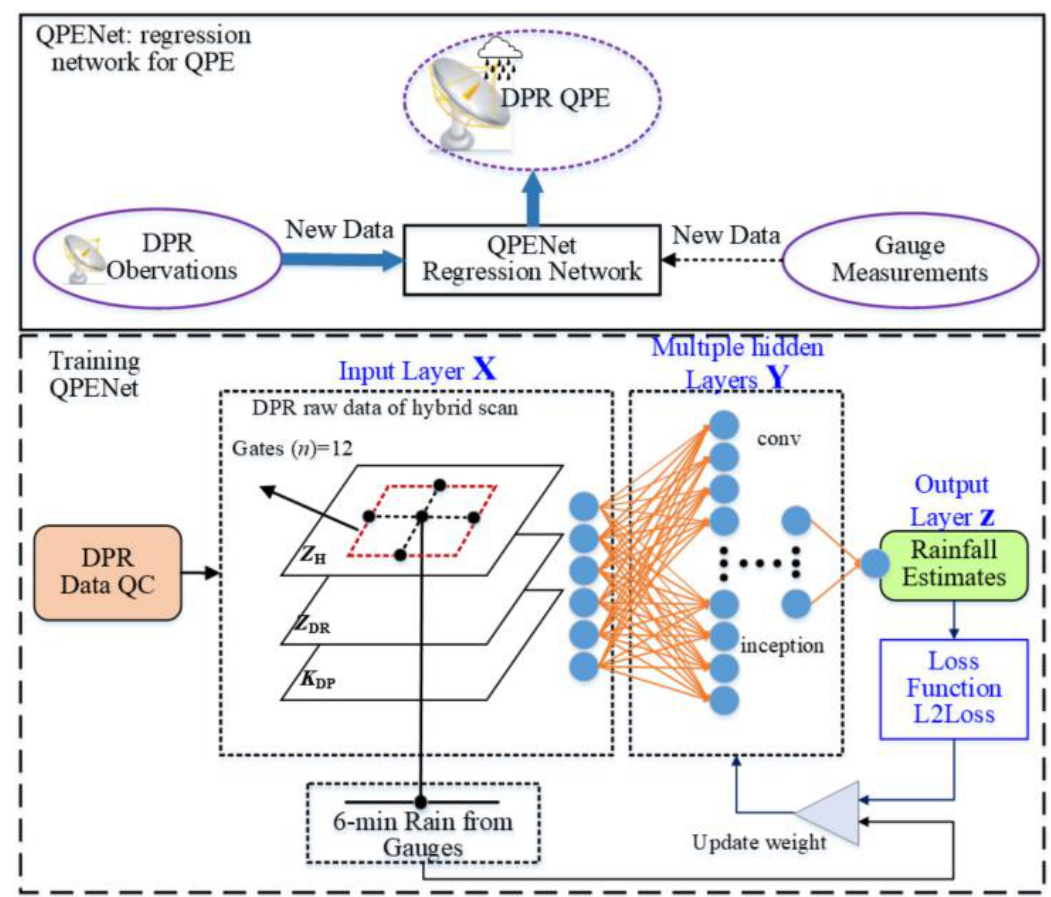
Figure 3. Simplified flowchart of the QPENet model structure and its application for polarimetric radar quantitative precipitation estimation.